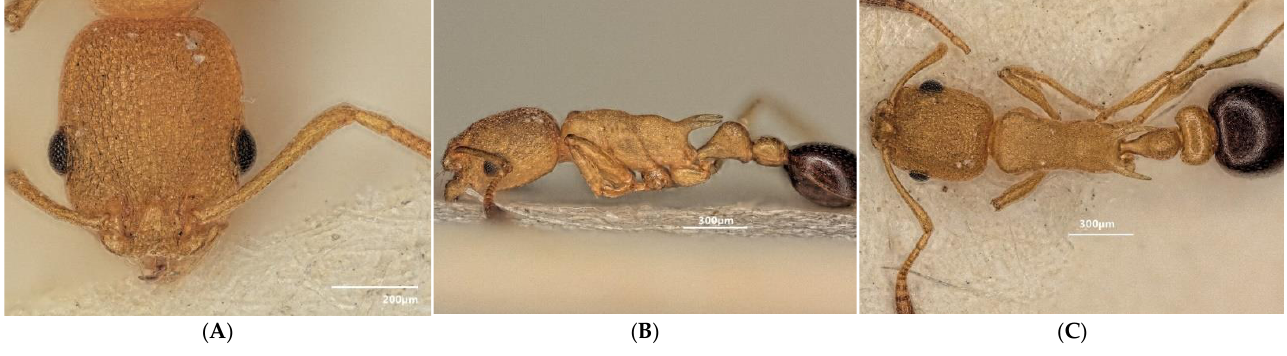
Figure 18. Cardiocondyla wheeleri , syntype: head in dorsal view ( A ), lateral view ( B ), dorsal view ( C ).